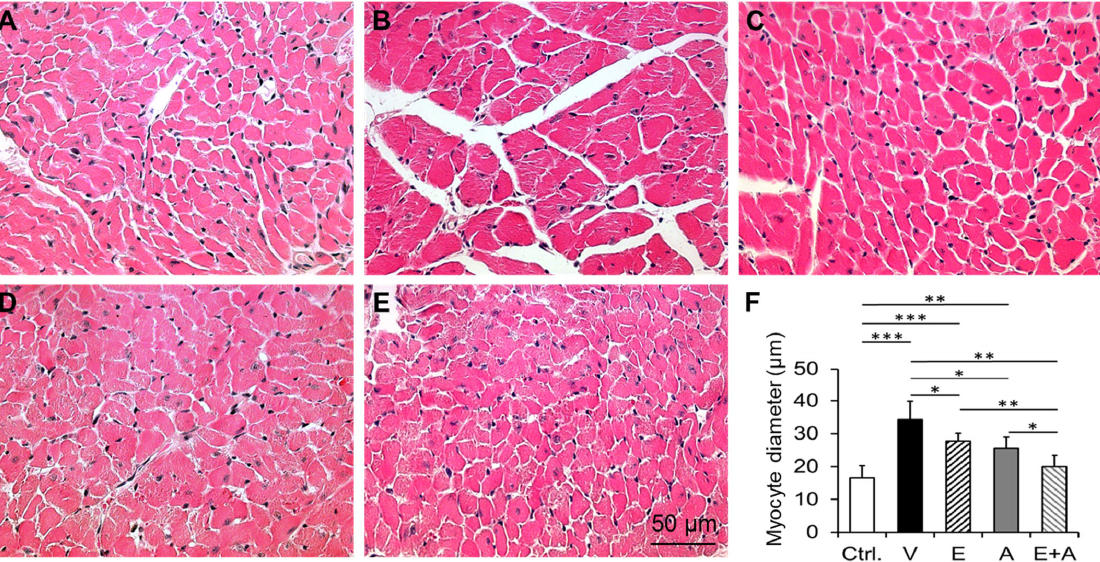
Figure 9. Changes in cardiomyocyte hypertrophy in diabetic ALDH2*2 mutant mice exhibiting HFpEF with vehicle, EMP, Alda ‐ 1 and EMP + Alda ‐ 1 treatments. Representative micrographs of hematoxylin ‐ eosin (H ‐ E) stained sections from control ( A ), vehicle ‐ treated ALDH2*2 mutant diabetic mice ( B ), EMP ‐ treated ALDH2*2 mutant diabetic mice ( C ), Alda ‐ 1 treated ALDH2*2 mutant diabetic mice ( D ) and EMP and Alda ‐ 1 combinedly treated ALDH2*2 mutant diabetic mice ( E ). The quantification of cardiomyocyte hypertrophy was shown ( F ). Data are presented as mean ± standard error of the mean (SEM). We have randomly picked n = 4 from the 8 mice. * p < 0.05, ** p < 0.01 and *** p < 0.001 refer to the difference between individual groups as shown.